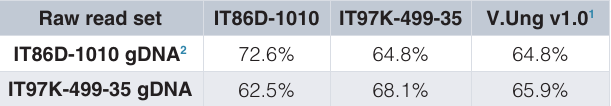
Table 2. Proportion of filtered DNA paired-end reads that uniquely align to the assembled genomic DNA sequence sets from IT97K-499-35 and IT86D-1010, and to the Vigna unguiculata genome v1.0 assembly of IT97K-499-35. IT86D-1010 and IT97K- 499-35 are the genome contig assemblies generated in this resource. Alignments were accepted if they were unique pair-end alignments within 1 kilobase of each other, with auto end-trimming of reads where required, and up to 3 mismatches per 100 base